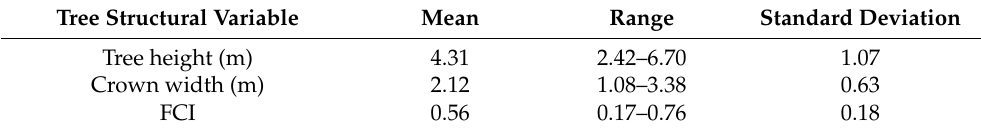
Table 1. Mean, range and standard deviation of tree height, crown width in east–west direction and first echo cover index (FCI) of Norway spruce tree objects. See Section 2.4 for detailed description of